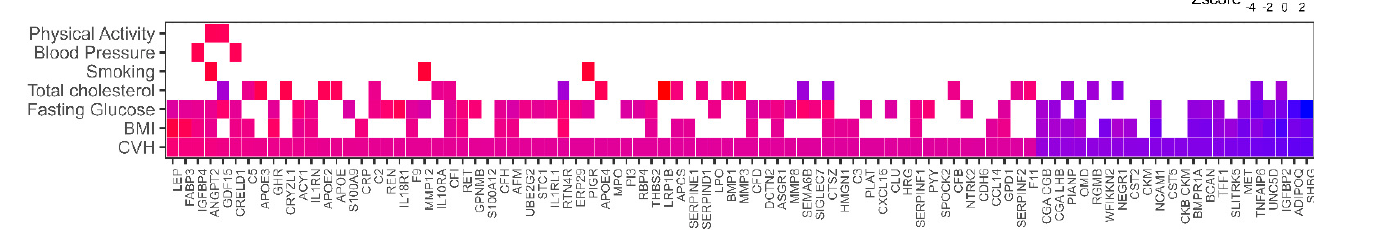
Figure 2. The mediating effect of individual plasma protein on the relationship between CVH and all-cause mortality. Higher CVH was negatively associated with all-cause mortality (white circle). Inclusion of individual plasma proteins significantly changed the magnitude of association (black circle), reflecting the mediation effect. Of the 92 CVH associated proteins, 33 proteins significantly mediated the relationship between CVH and all-cause mortality. 4. Discussion In this study we examined the plasma proteomic profiles associated with CVH, op- erationalized using the life simple 7 metric, to uncover the possible mechanisms underly- ing the protective effect of CVH on mortality. We found that ideal CVH had a significant impact on protein homeostasis that was reflected by the differential abundances of many proteins spanning different biological domains. Specifically, we identified a set of 92 pro- teins associated with CVH, and 33 of these proteins significantly mediated the association between CVH and mortality. The proteins identified represented different biological path- ways and health states including complement and coagulation cascade, growth hormone (GH) and insulin-like growth factor (IGF) pathway, obesity-related proteins, and aging